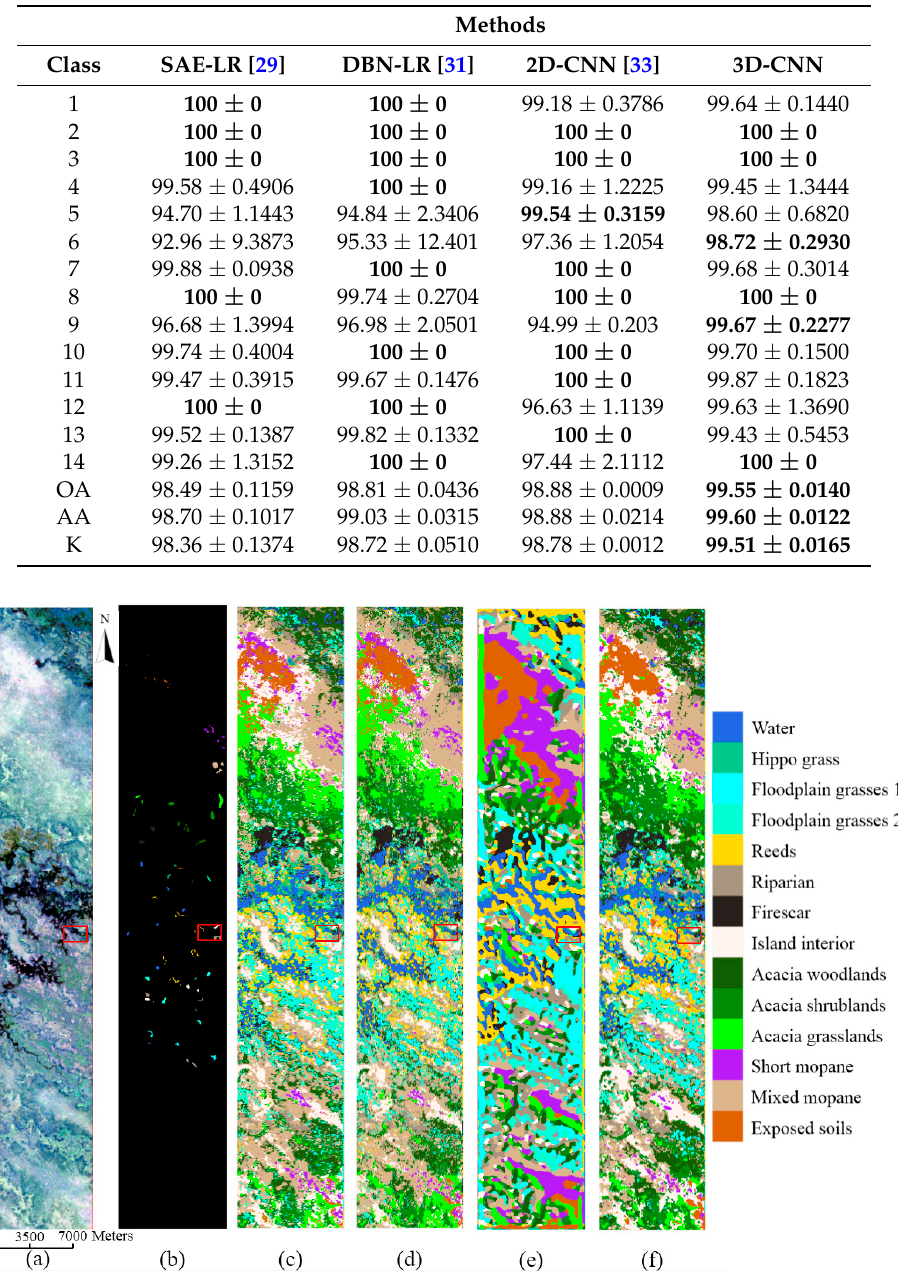
Figure 10. Classification results of Botswana scene. ( a ) False-color composite; ( b ) Ground truth; ( c ) SAE-LR, OA = 98.49%; ( d ) DBN-LR, OA = 98.81%; ( e ) 2D-CNN, OA = 98.88%; ( f ) 3D-CNN, OA = 99.55%.